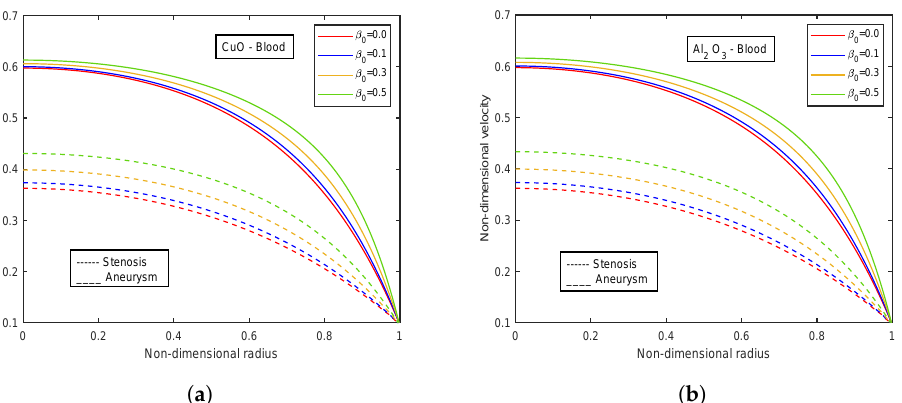
Figure 17. Impact of viscosity parameter β 0 on velocity profiles for ( a ) CuO-nanoparticles, ( b ) Al 2 O 3 -